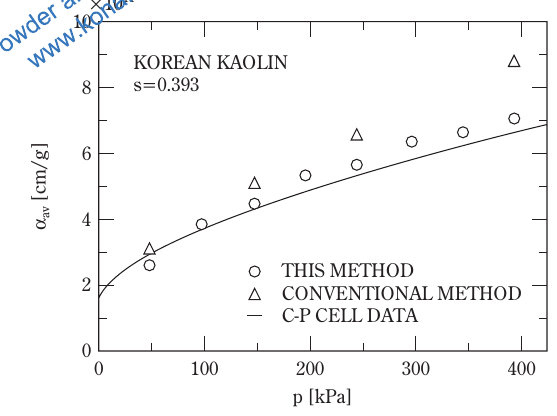
Fig. 4 Relation between average specific filtration resistance and applied filtration